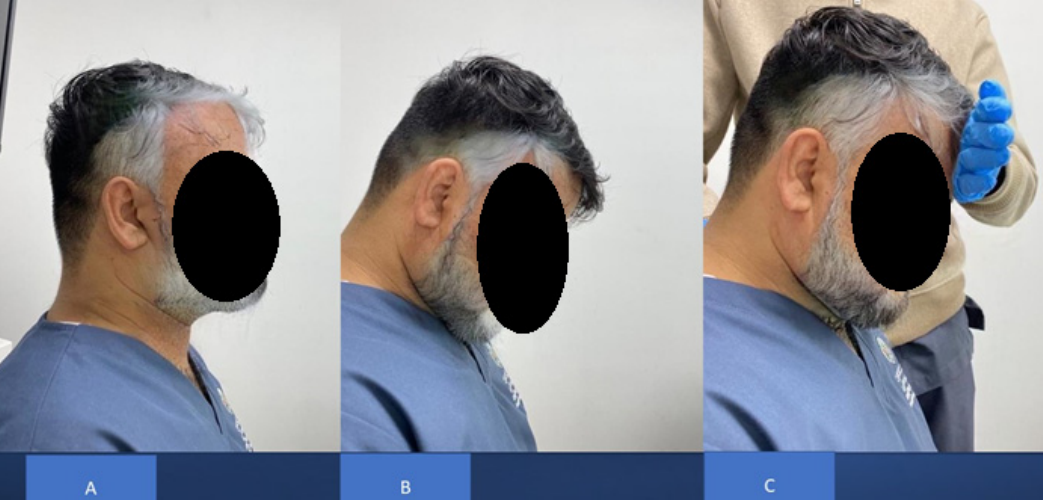
Figure 5. The chin drop exercise: ( A ) the starting position; ( B ) the end stretching position; ( C ) a modification of the chin tuck that further emphasizes strengthening of the deep neck flexor muscles.